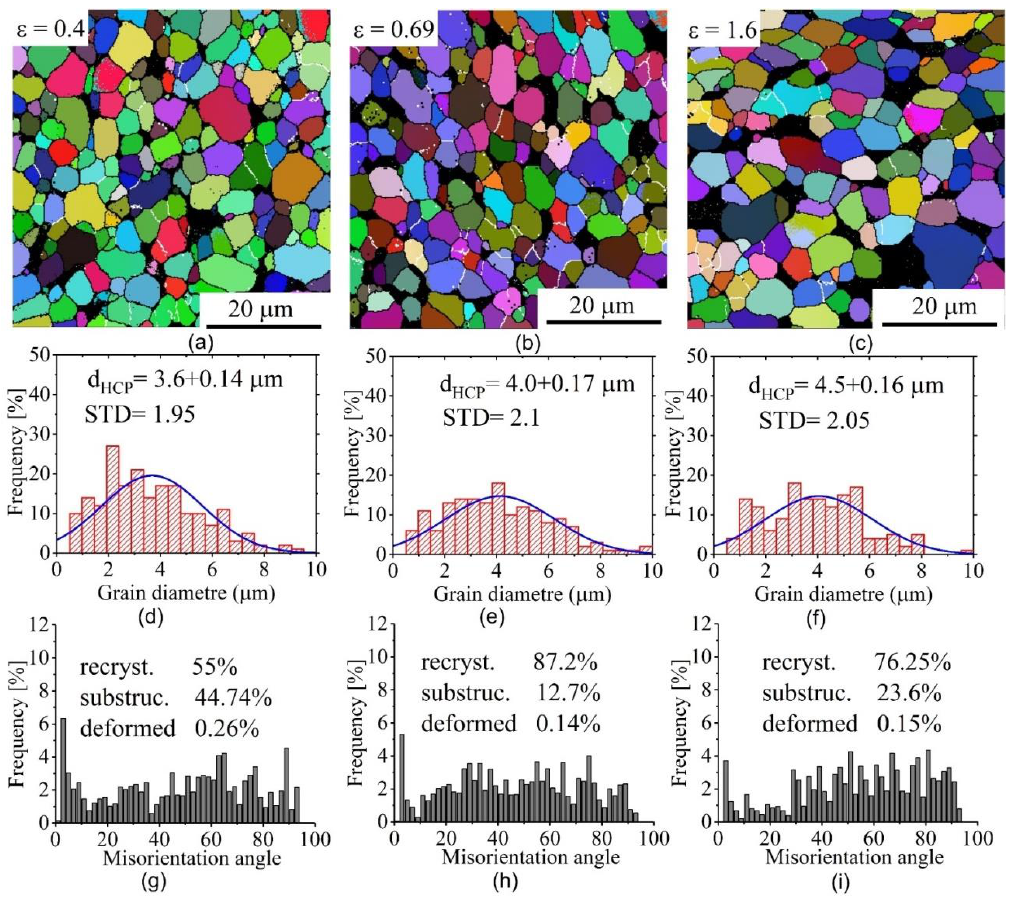
Figure 6. Electron backscattered diffraction (EBSD) grain-subgrain boundaries maps ( a – c ), grain size distribution ( d – f ) and the misorientation angle ( g – i ) at 1 × 10 -3 s -1 and 875 °C for the HCP phase.